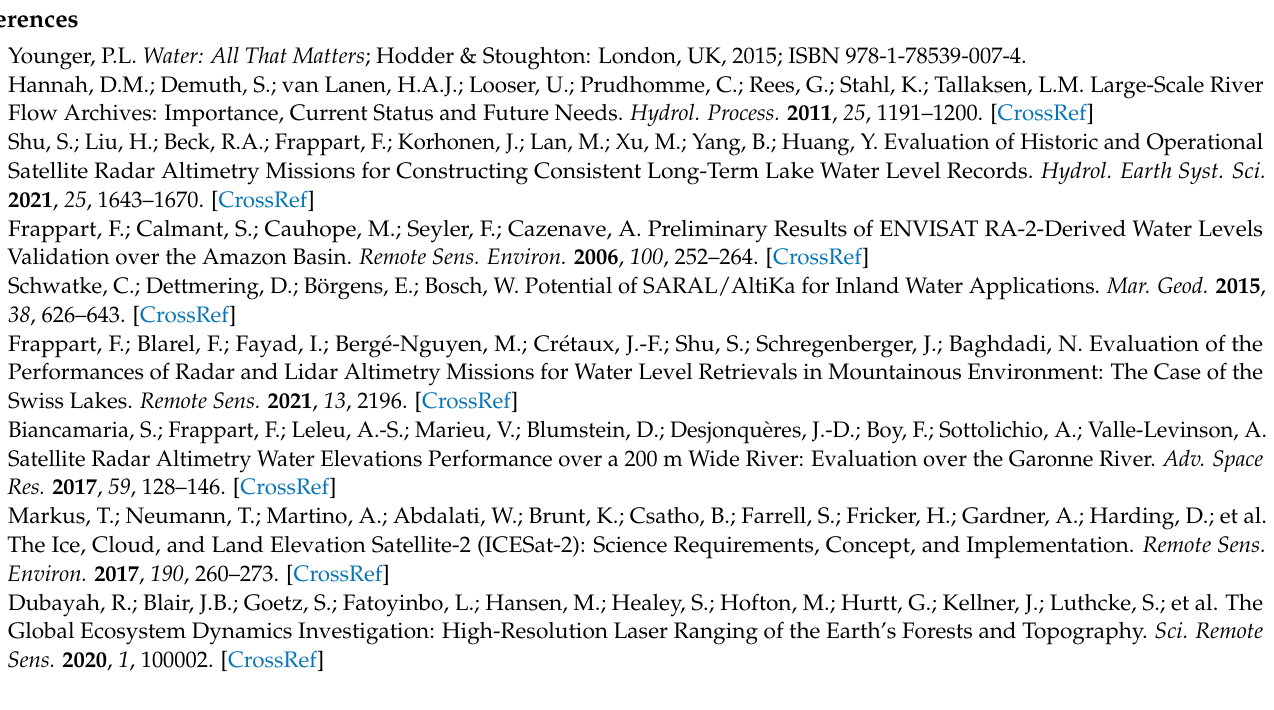
Figure A11. Variables’ order of importance in the error estimation random forest regression model with the percentage mean increase in MSE (%IncMSE) (higher values mean higher importance). WW represents wind generated waves variables. SW represents swell waves variables.